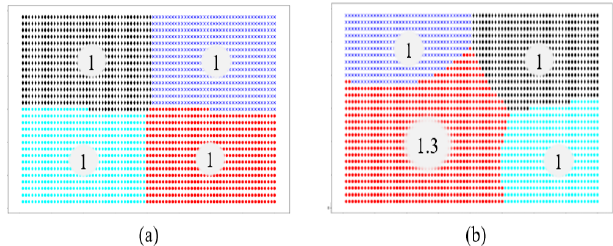
Figure 4. The area partition based on an MW Voronoi diagram in four robot cases: ( a ) the area divided into four sub-areas with the same weights and ( b ) the area divided into four sub-areas by a weight of 1.3 for one